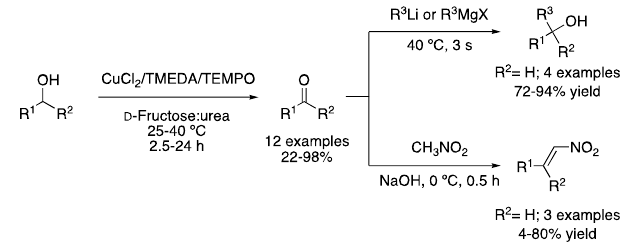
Figure 2. Oxidation of alcohols in DES and telescoped one-pot reactions.